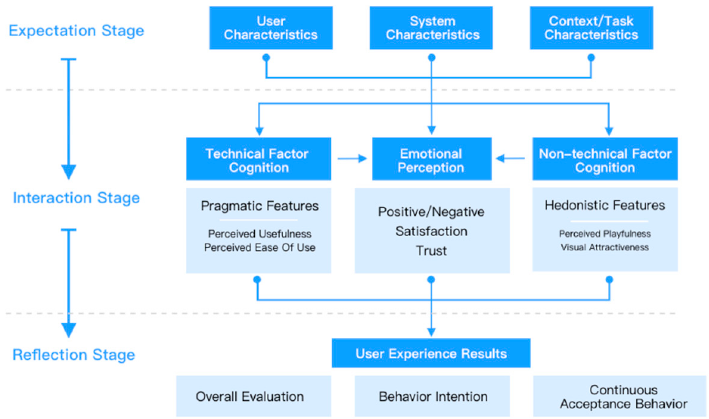
Figure 1. A dynamic phase framework for user experience.